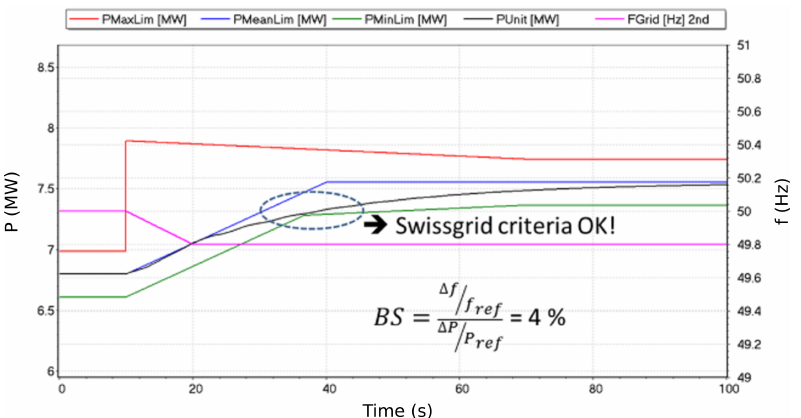
Figure 8. Simulated frequency response scenario meeting Swissgrid criteria with a permanent droop of BS = 4%. PMaxLim is the limit of the maximum power accepted, PMeanLim is the limit of the mean power maximum accepted, PMinLimit is the limit of the minimal power accepted, PUnit is the power of the unit simulated, and FGrid is the frequency of the grid.